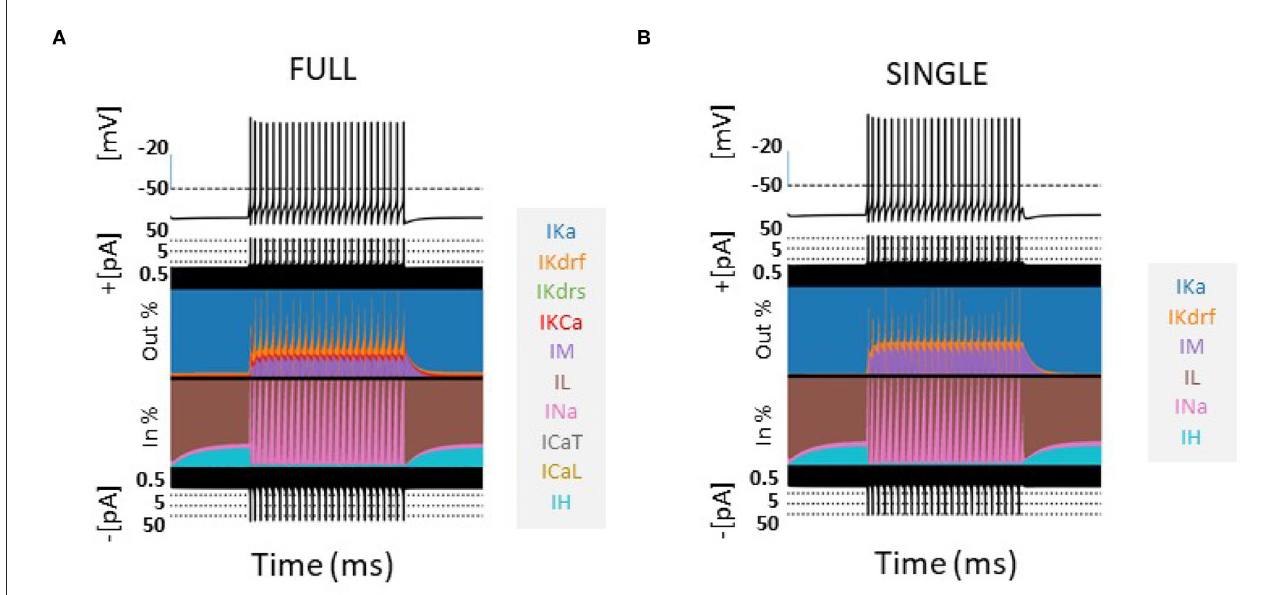
FIGURE1 Comparison of models-FULL and SINGLE. Currentscapes (Alonso and Marder, 2019) are shown for models of FULL (somatic location) (A) and SINGLE (B) . Their firings are similar and corresponding biophysical currents have similar balances. Simulations were conducted for 4,000 ms, with a holding current of 4 pA throughout. A step current of 60 pA was injected at 1,000 ms for 2,000 ms. Comparisons at other step currents are provided in Supplementary